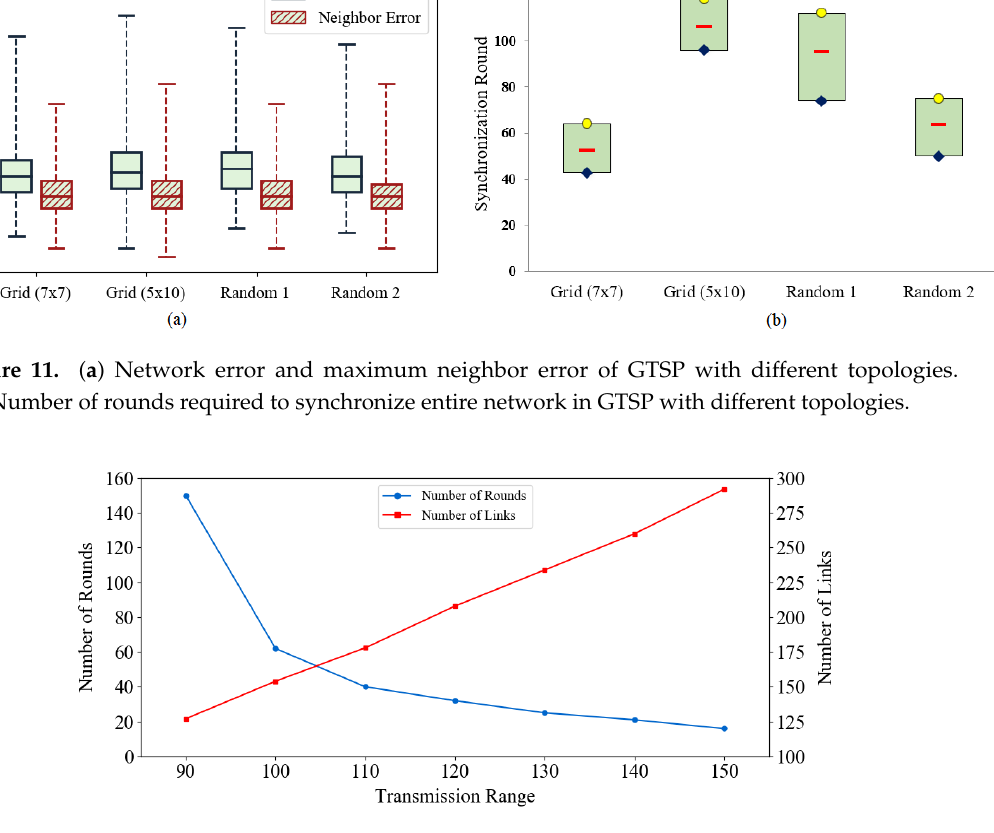
Figure 12. Number of rounds required to synchronize entire network in GTSP with different transmission